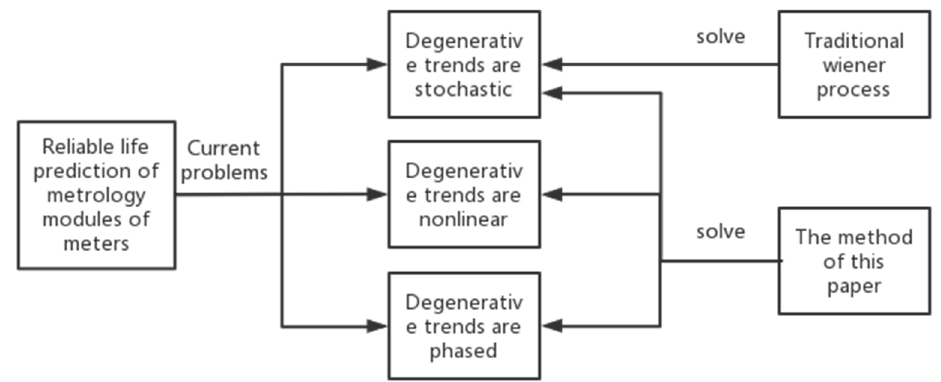
Figure 1. Conceptual diagram of the problem addressed in this paper.